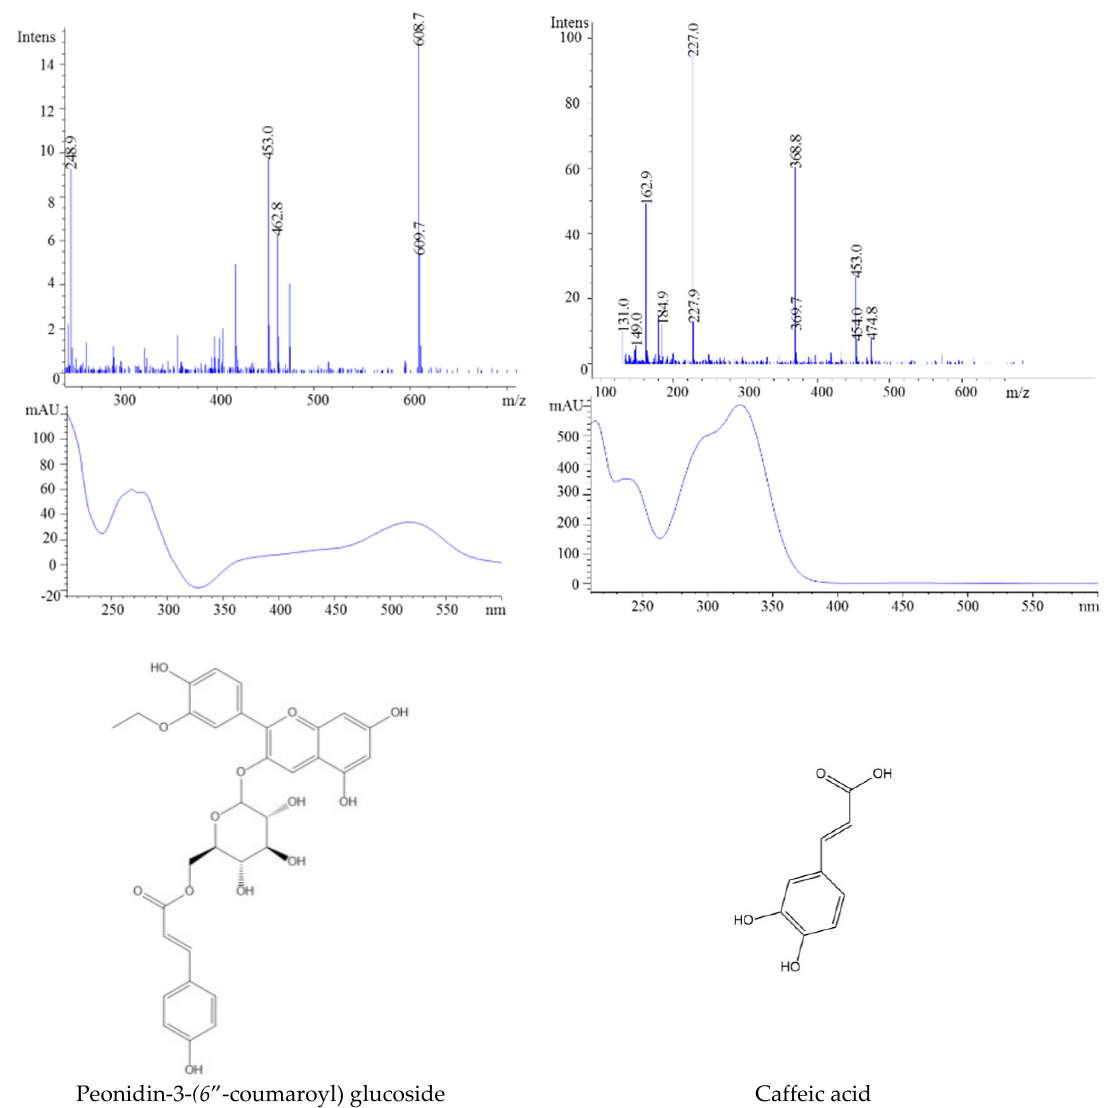
Figure 5. HPLC-MS spectra, UV/vis scanning spectra, and the chemical structures of peaks 1 and 7.